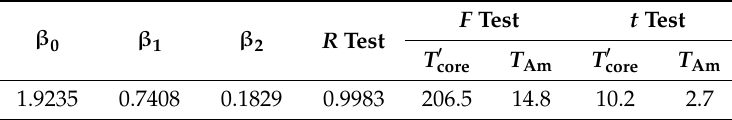
Table 8. The parameter vector values in